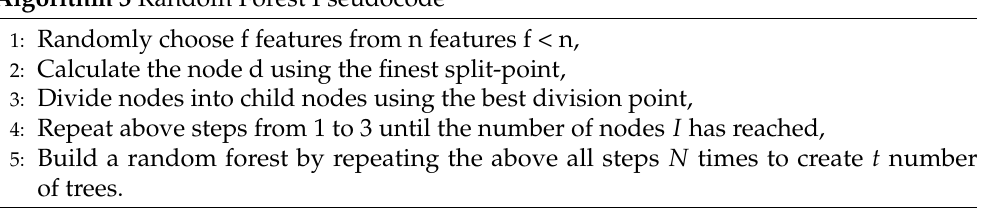
Algorithm 3 Random Forest Pseudocode